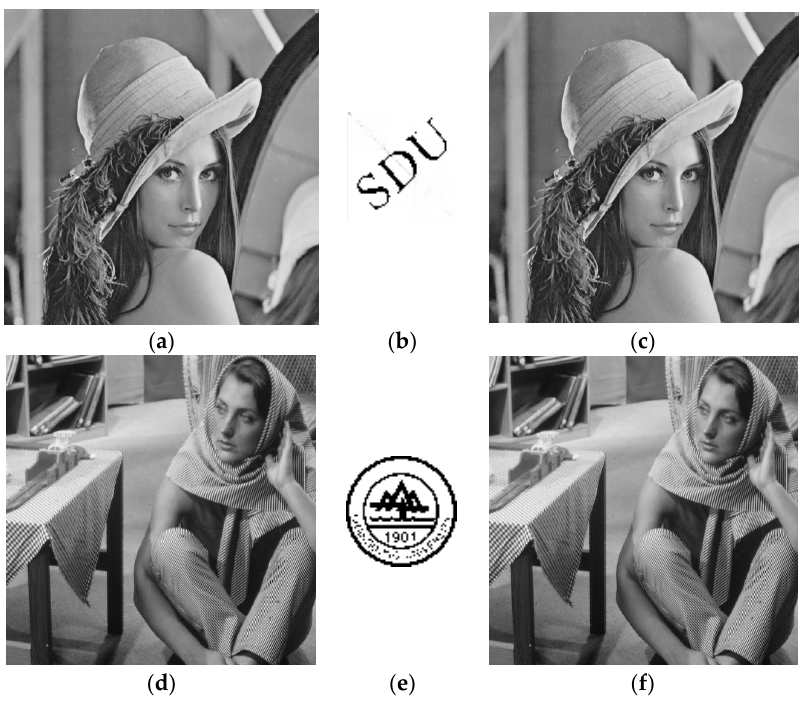
Figure 9. Imperceptibility of the watermark: ( a ) original Lena image; ( b ) original character watermark w 1 ; ( c ) watermarked Lena; ( d ) original Barbara image; ( e ) original logo watermark w 2 ; ( f ) watermarked Barbara.